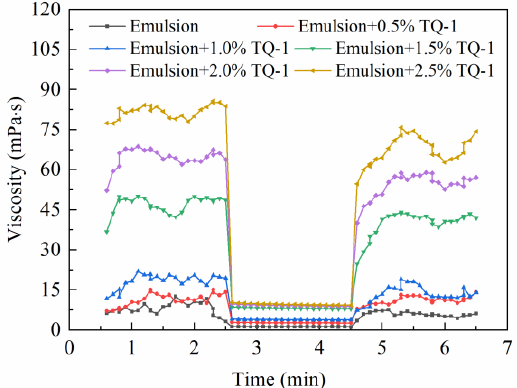
Figure 8. Three interval thixotropic curves of the invert emulsions under different TQ-1 concentra-